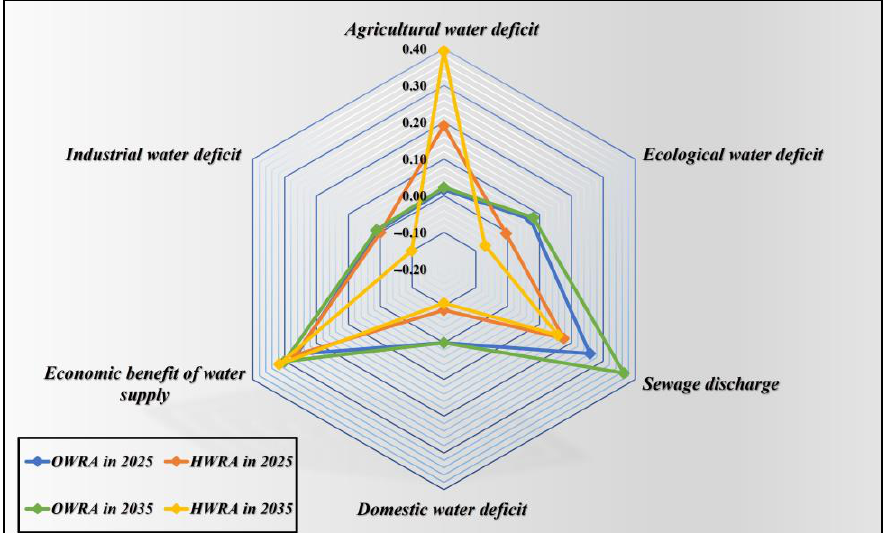
Figure 6. Radar chart comparison of the results of the HWRA and OWRA models.